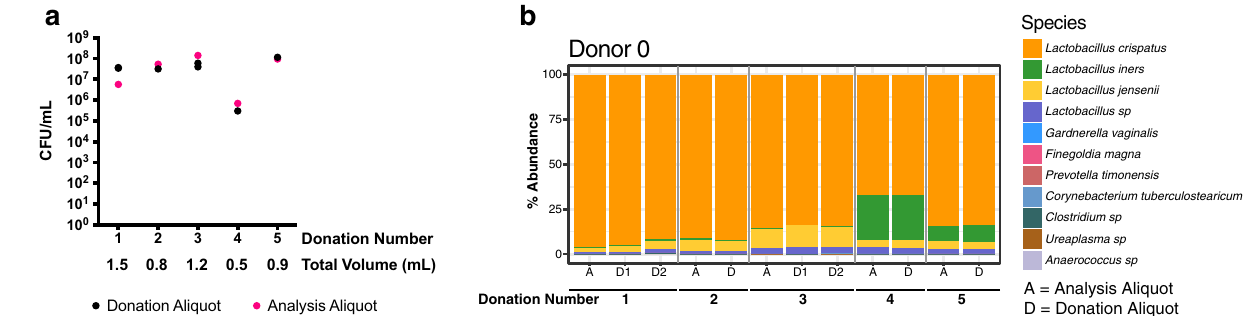
Figure 1. Microbial community profiling and absolute quantification of pilot donation fluid. ( a ) Lactobacillus colony forming unit (CFU) quantification for each donation and analysis aliquot. Total donation volume is listed below donation numbers. ( b ) Microbial species in donation (“D”) and analysis (“A”) aliquots of pilot donor (Donor 0) samples using bacterial 16S rRNA amplicon sequencing. D1 and D2 refer to two different donation aliquots from the same donation